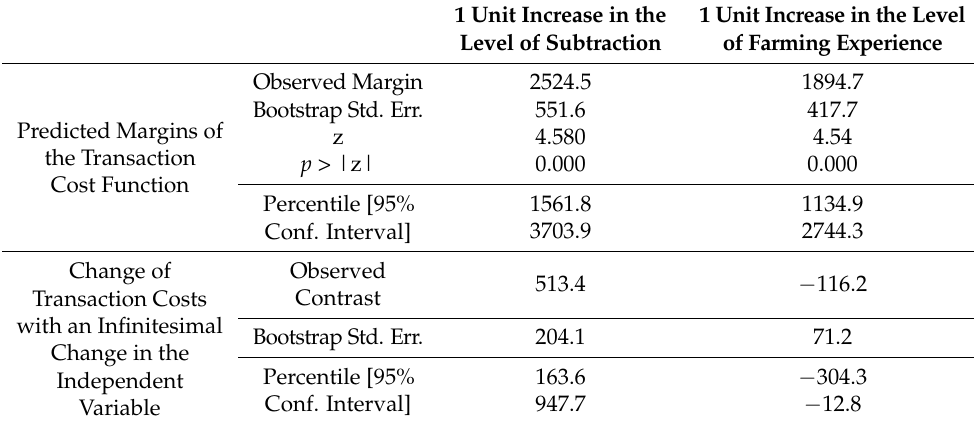
Table 8. Prediction according to transaction cost function of model 6 (N =